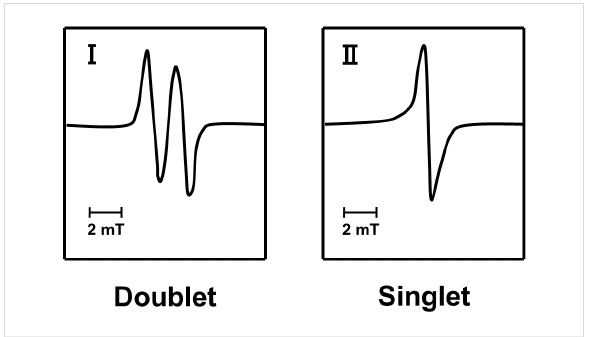
Figure 6: Component spectra of the simulated ESR